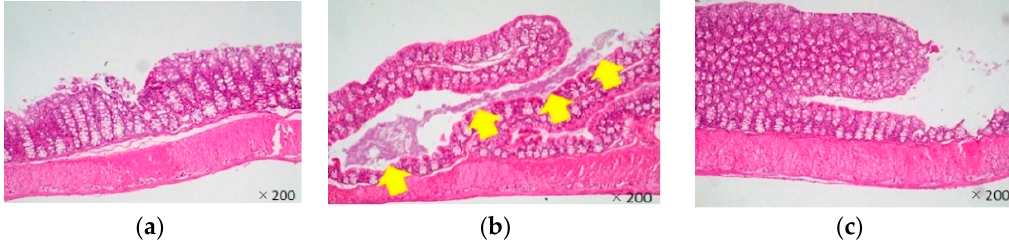
Figure 3. Effects of Lonicera japonica flower bud extract (LJFE) on the large intestine histology of Citrobacter -infected mice. Hematoxylin and eosin staining were performed. The yellow arrow points to the bacterial mass. ( a ) Normal mouse, ( b ) Citrobacter -infected control group without LJFE-treatment, ( c ) Citrobacter -infected group treated with LJFE (2 g/kg).